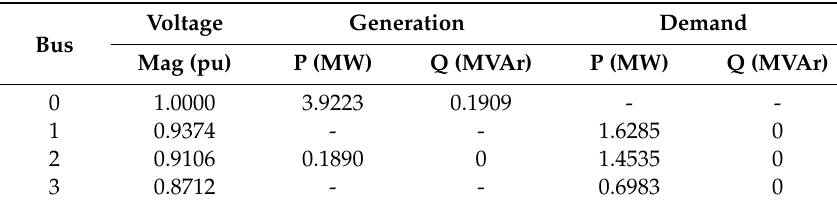
Table 2. Original bus data.